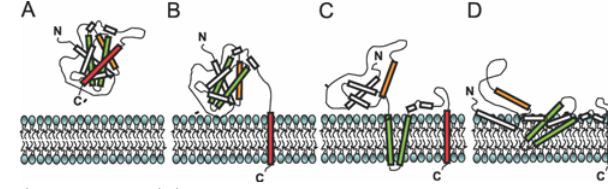
Figure 2. Putative Conformations of Bcl-XL with α-Helices 2 (BH3 Domain), 5–6 (Central Hairpin), and 9 (C-Terminal Hydrophobic Tail) Depicted in Orange, Green, and Red, Respectively (A) Structure of Bcl-XL in solution. (B) Membrane-integrated conformation of Bcl-XL in which the C-terminal tail is inserted into the membrane in a transmembrane orientation, while the remainder of the protein maintains the solution structure. In this conformation, the BH3-binding pocket of Bcl-XL is expected to be available to engage in inhibitory groove–BH3 interactions with pro-death Bcl-2 family proteins, such as tBid and Bax, as is seen in solution-based binding studies. (C) Membrane-integrated conformation of Bcl-XL in which the C-terminal tail and the central helical hairpin are inserted into the membrane. In this conformation, the BH3-binding pocket of soluble Bcl-XL is expected to be substantially modified or destroyed. However, Bcl-XL may still engage in neutralizing interactions with Bax, as previously proposed for Bcl-2 [20]. Alternatively, this conformation may correspond to functionally silent Bcl-XL, pro-apoptotic Bcl-XL, or a yet unknown function of Bcl- XL. (D) Membrane-integrated conformation of Bcl-XL, in which many different helical regions of the protein are inserted in the membrane, but with different orientations and at different penetration depths. In this conformation, the BH3-binding pocket of soluble Bcl-XL no longer exists. Nevertheless, it is conceivable that Bcl-XL inhibits pro-apoptotic proteins through interaction surfaces other than the groove and/or via interactions with membrane lipids. Alternatively, this conformation may correspond to functionally silent, pro-apoptotic, or a yet unknown function of Bcl-XL. We postulate that the topology adopted by Bcl-2-type proteins in the membrane can be modulated by changes in membrane lipid